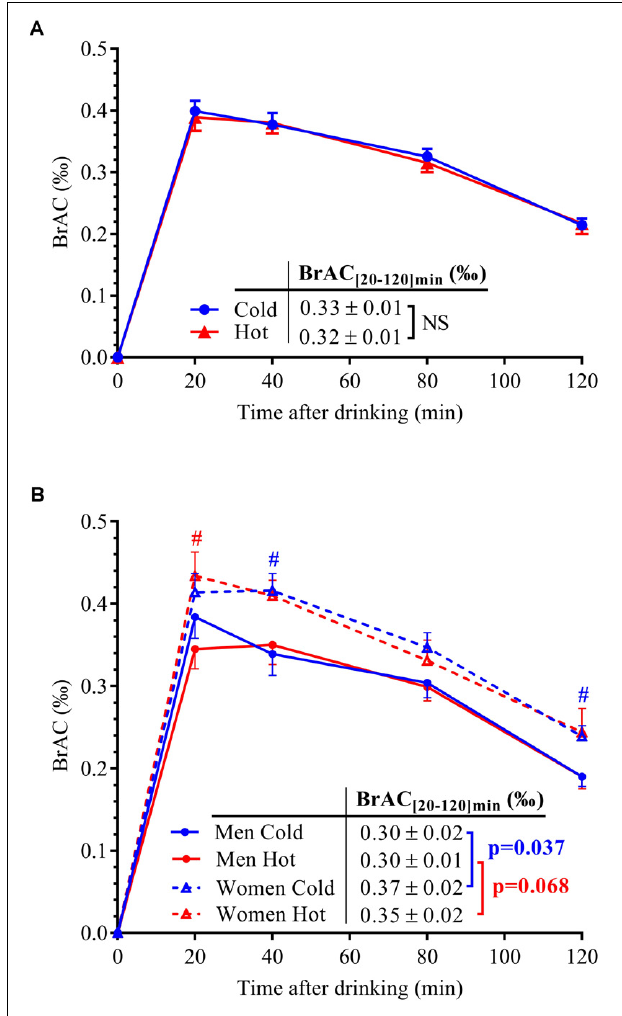
FIGURE 2 | (A) BrAC over time after alcohol ingestion in the 14 subjects. (B) BrAC data were separated by sex (seven men: solid lines and seven women: dotted lines) for both drink temperatures of ingestion (blue lines: cold wine; red lines: hot wine). Area under the concentration–time curve for BrAC between 20 and 120 min post-drink ingestion, i.e., mean BrAC [ 20 - 120 ] min ( was indicated according to sex and drink conditions, with corresponding p -values computed by unpaired t -test. All data are mean ± SEM. # p < 0.05 significant difference between men and women (unpaired t -tests).